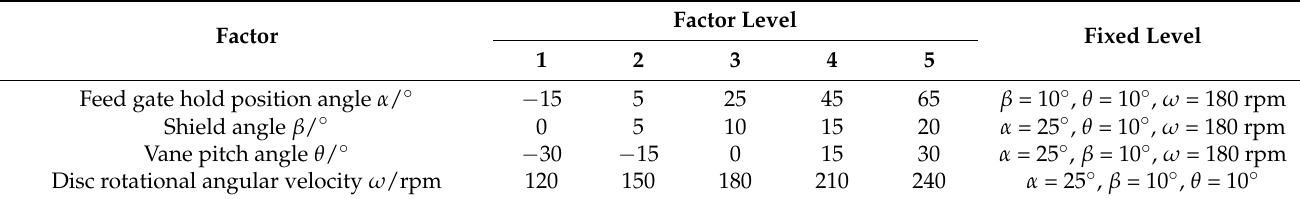
Table 2. Simulation design of single-factor trials.